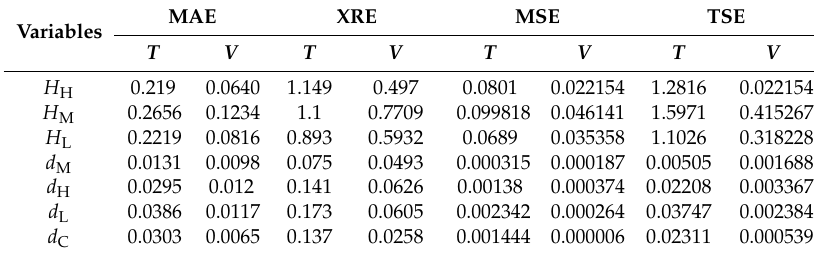
Table 4. Model performance criteria summary using the punctual approach.